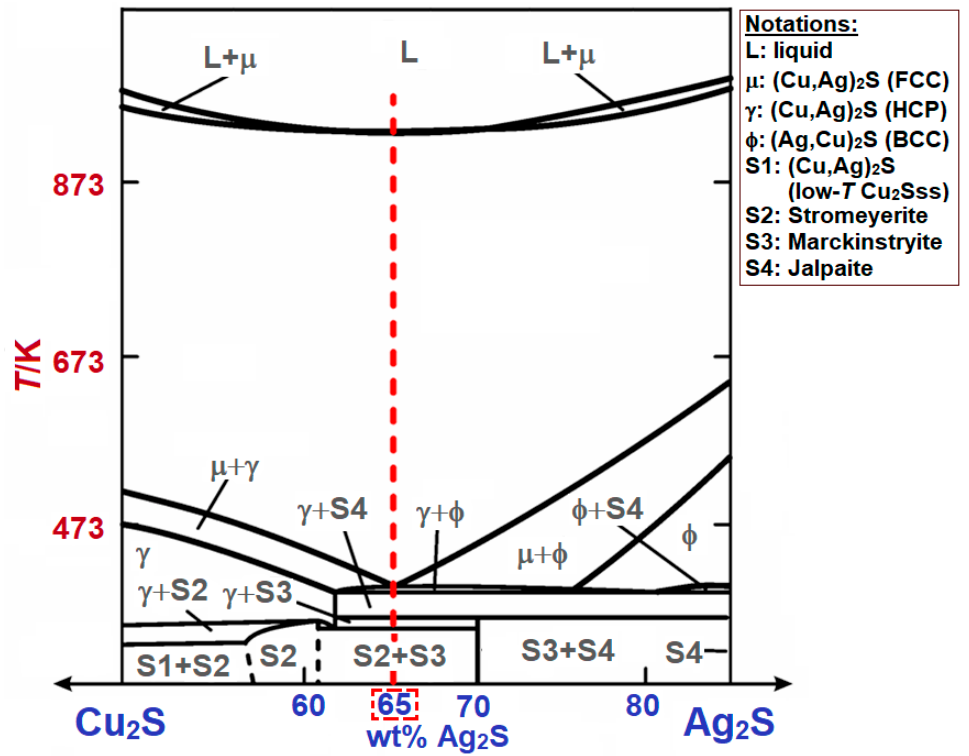
Figure 6. A portion of phase diagram of the binary Ag 2 S-Cu 2 S system (depicted based on the information presented in [20]). The red dashed line indicates the temperature range and composition of the sample for which the DSC-TGA measurements were conducted.